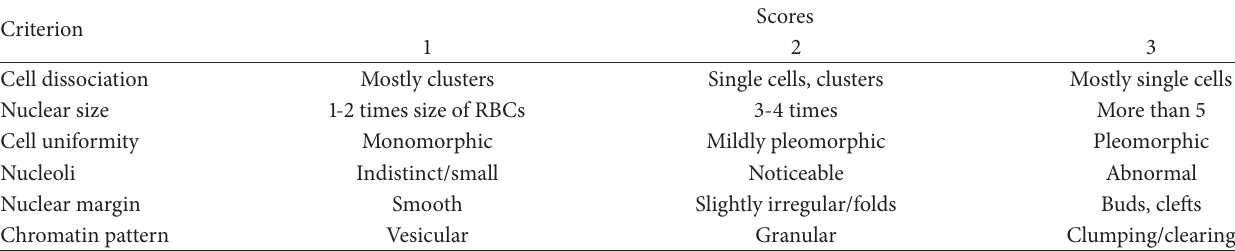
Table 1: Cytological grading with the method of Robinson et al.